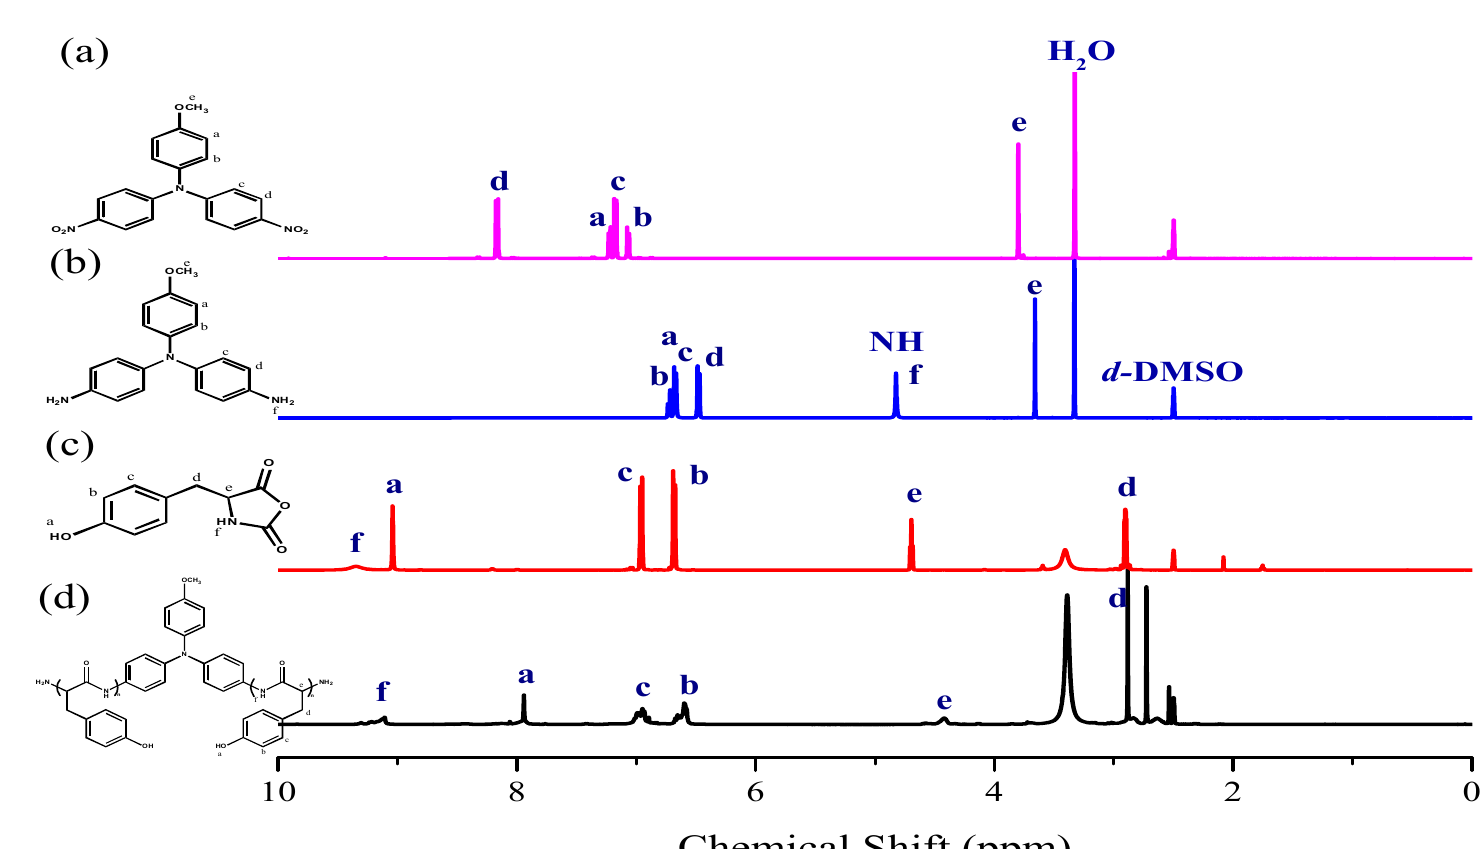
Figure 2. 1 H NMR spectra of: ( a ) TPA-NO 2 ; ( b ) TPA-NH 2 ; ( c ) Tyr-NCA monomer; and ( d ) PTyr-TPA.